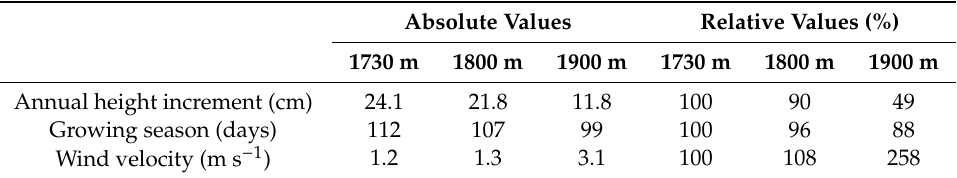
Table 1. Mean annual height increment of young Pinus cembra trees, mean growing season length, and mean wind velocity during the growing season at various altitudes in a subalpine a ff orestation in the Sellrain valley, Tyrol, Austria. Relative values are given as percentage of data from 1730 m a.s.l. After